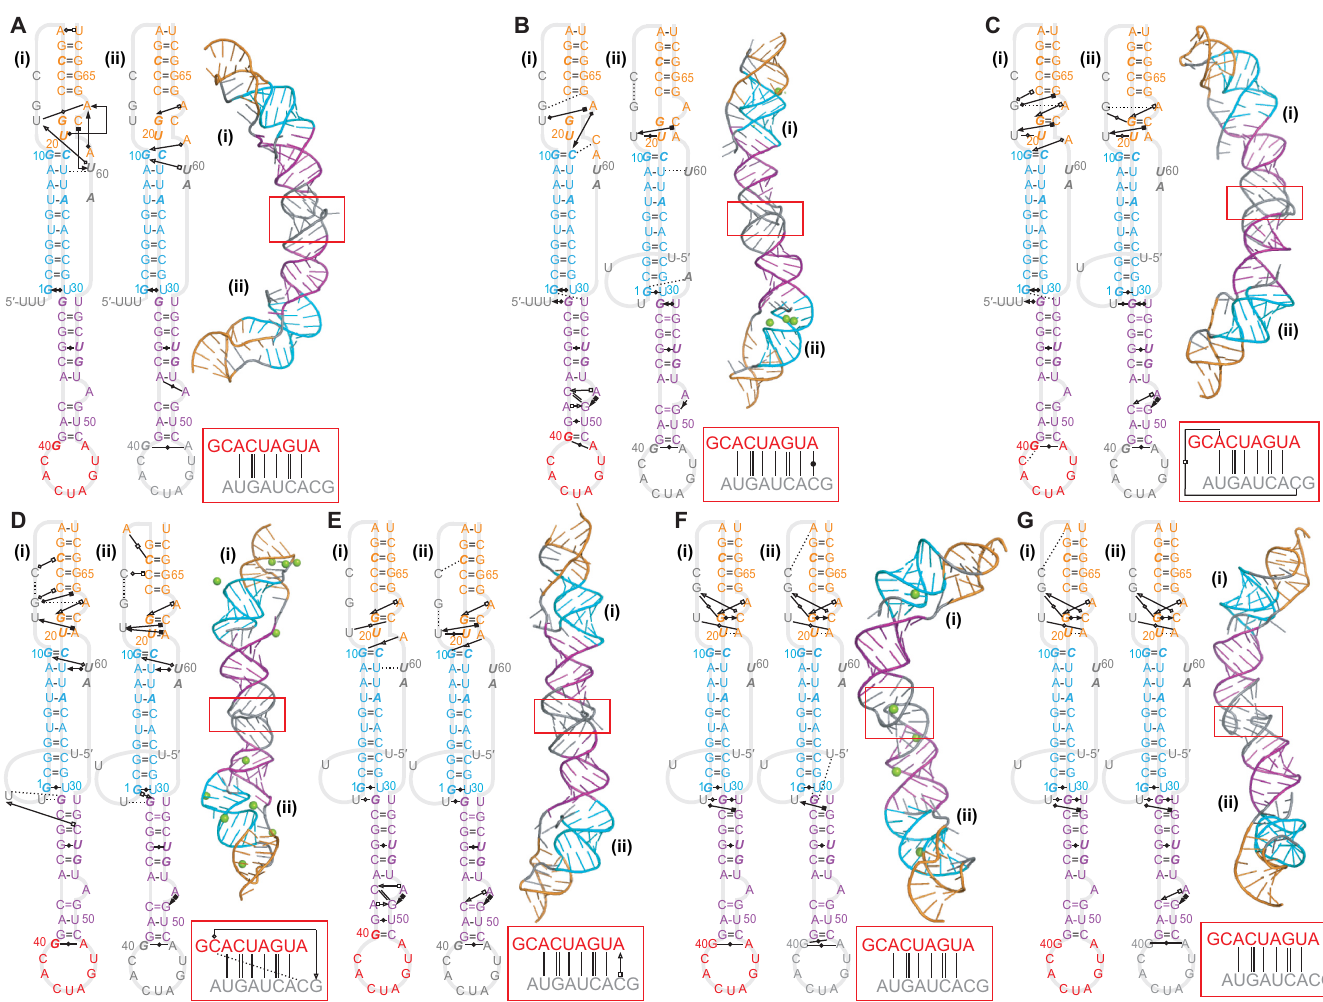
Fig 7. Representative dimer structures from MD simulations. Secondary structures and representative 3D structures of the most populated clusters for the models consistent with experimental data. (A) Unthreaded/unthreaded dimer without Mg 2+ . (B) Unthreaded/5 0 -threaded dimer with Mg 2+ . (C) Unthreaded/5 0 -threaded dimer without Mg 2+ . (D, E) 5 0 -threaded/5 0 -threaded dimer from FARFAR2 with (D) and without (E) Mg 2+ . (F, G) 5 0 -threaded/5 0 -threaded dimer from SimRNA with (F) and without (G) Mg 2+ . In each case, the interactions in the dimerization domain are shown in the red box.